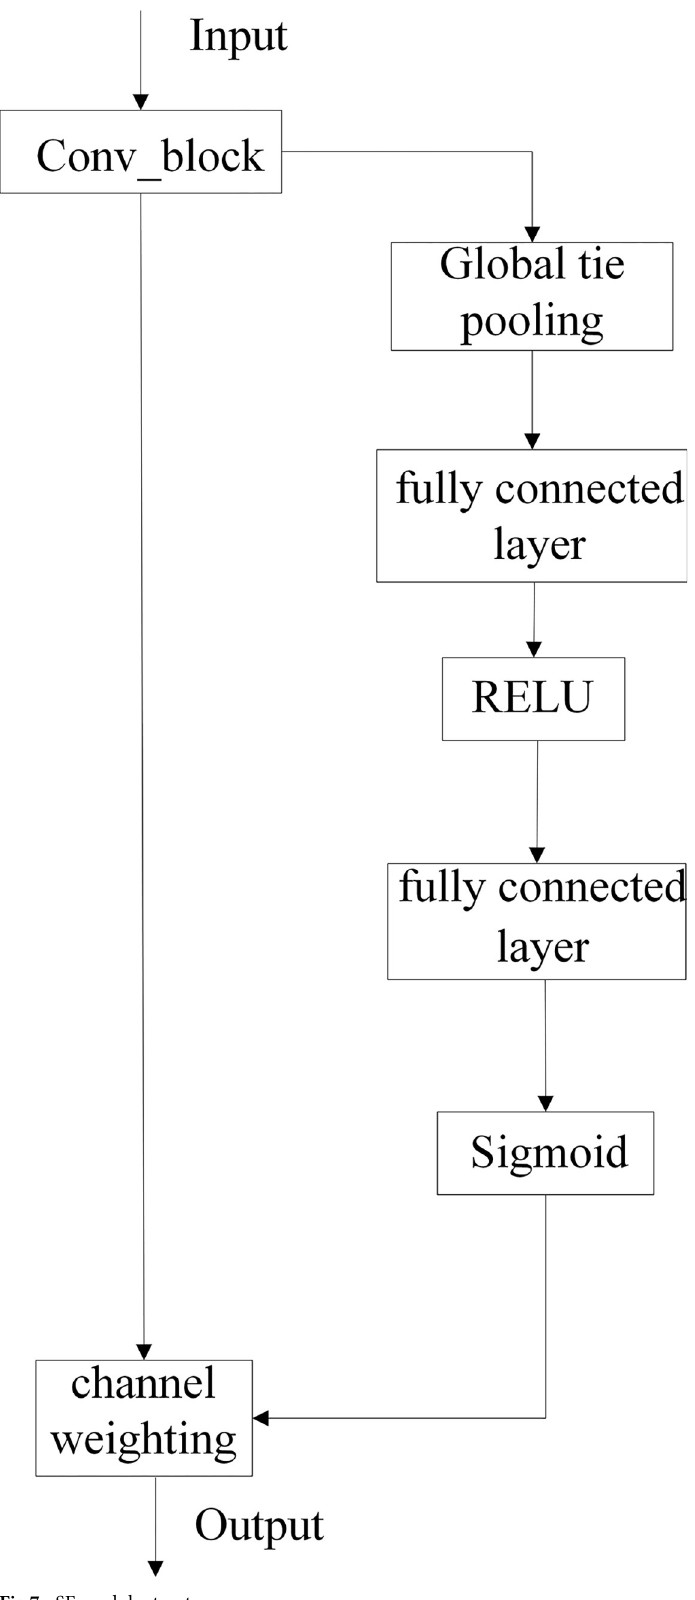
Fig 7. SE module